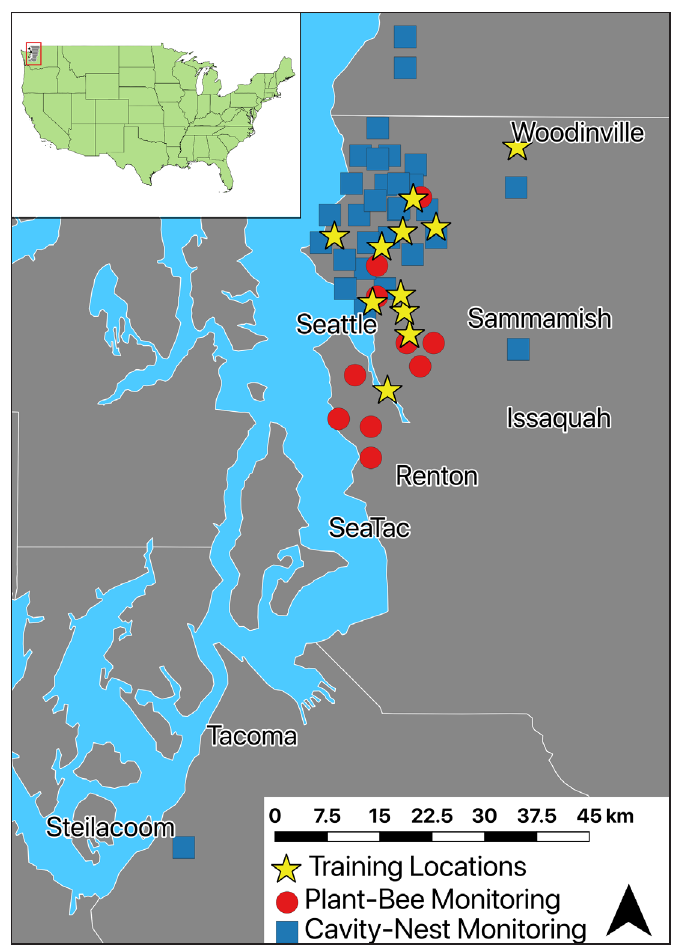
Figure 1: Scope of the study. Shown are training locations (yellow stars), plant-bee network monitoring sites (red dots), and habitat preference evaluation sites (blue